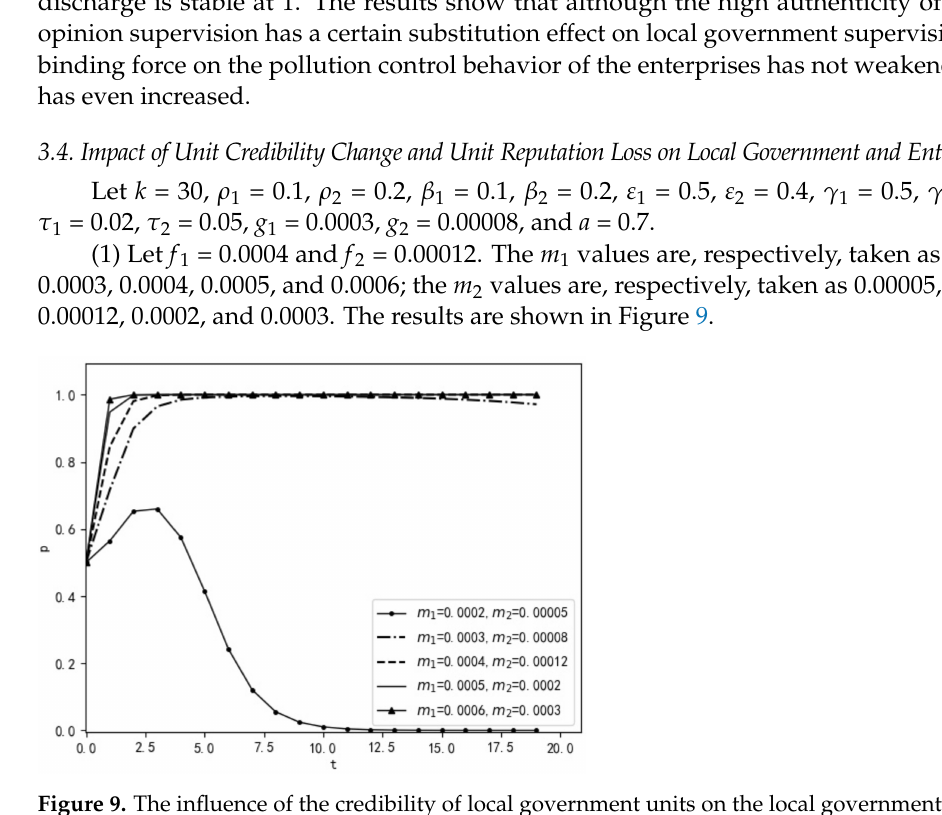
Figure 9. The influence of the credibility of local government units on the local